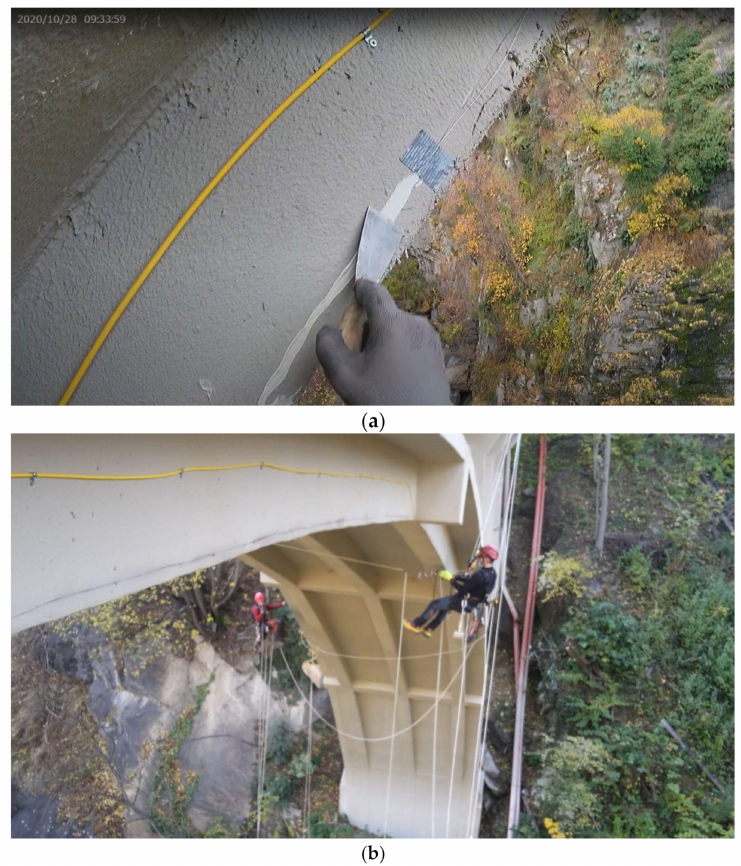
Figure 4. ( a ) A frame from the webcam mounted on the climber helmet during the D-FOS strain cable installation; ( b ) Climbers at work on the bridge. The concrete milling before the positioning of the D-FOS strain cable is visible in the